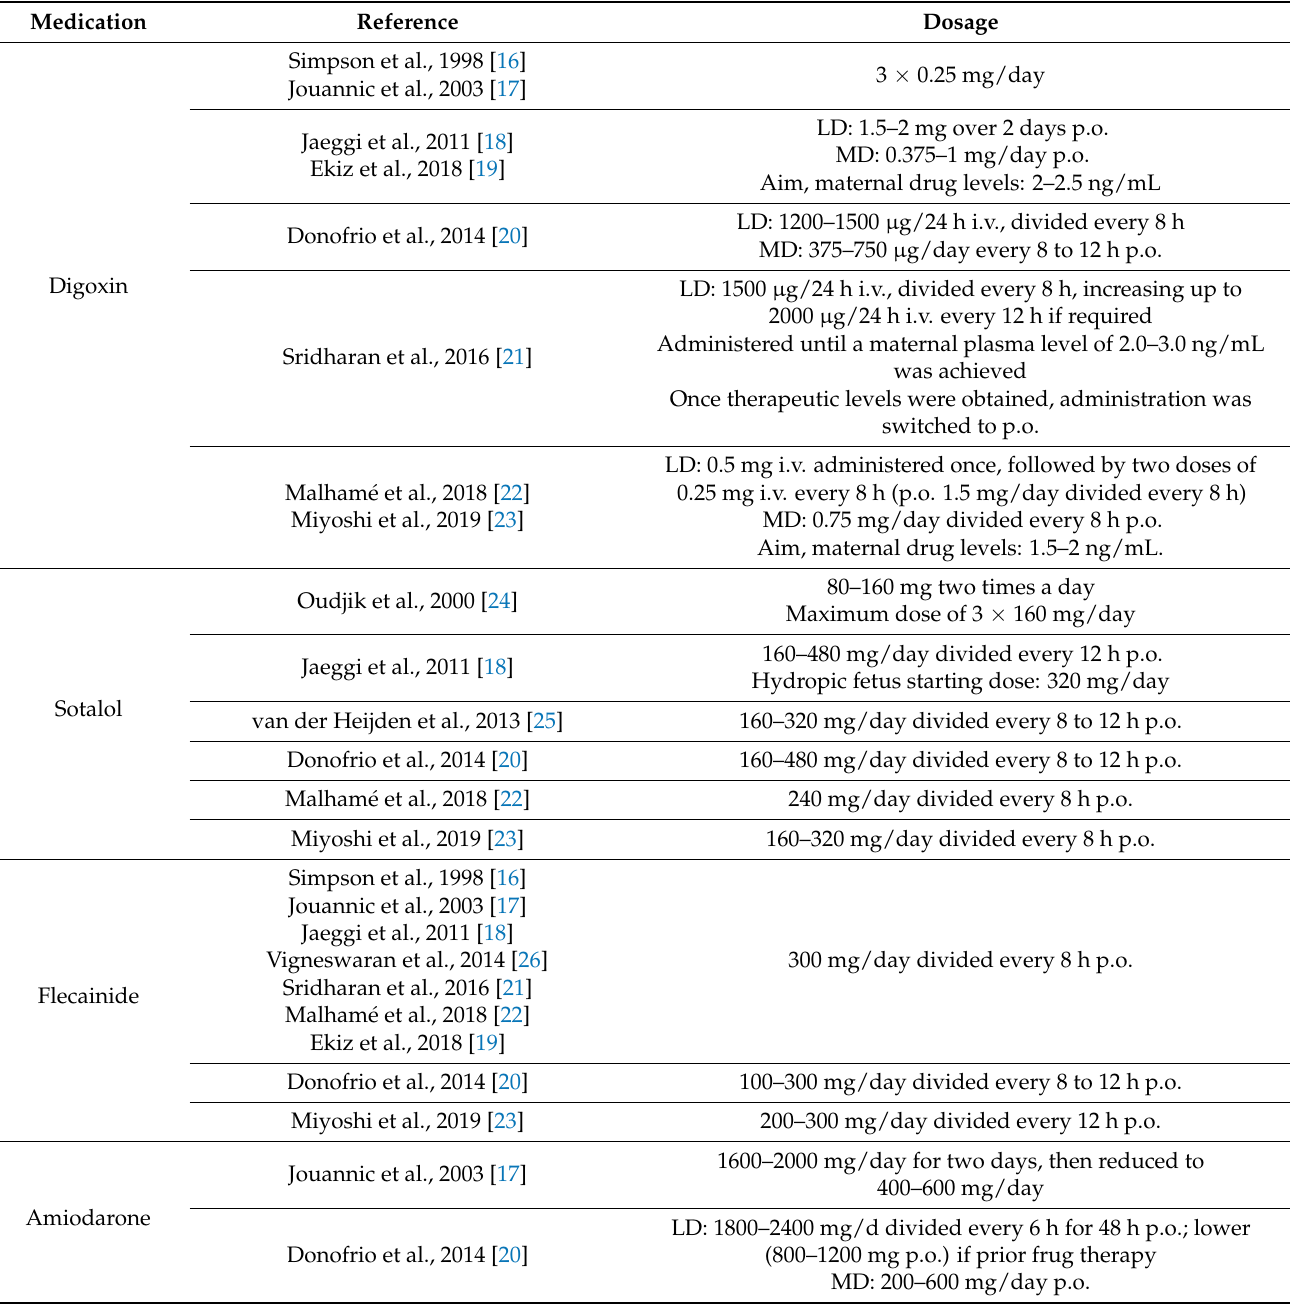
Table 1. Transplacental antiarrhythmic drugs and recommended